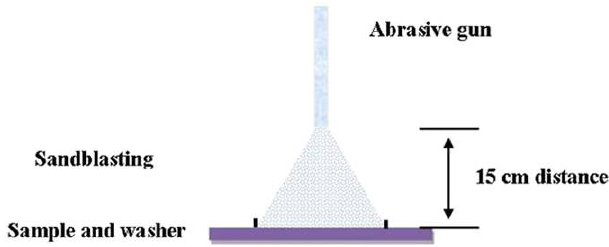
Figure 11. Schematic of micro-sand blasting test. Reprinted from [119] with permission; Copyright Elsevier 2016.